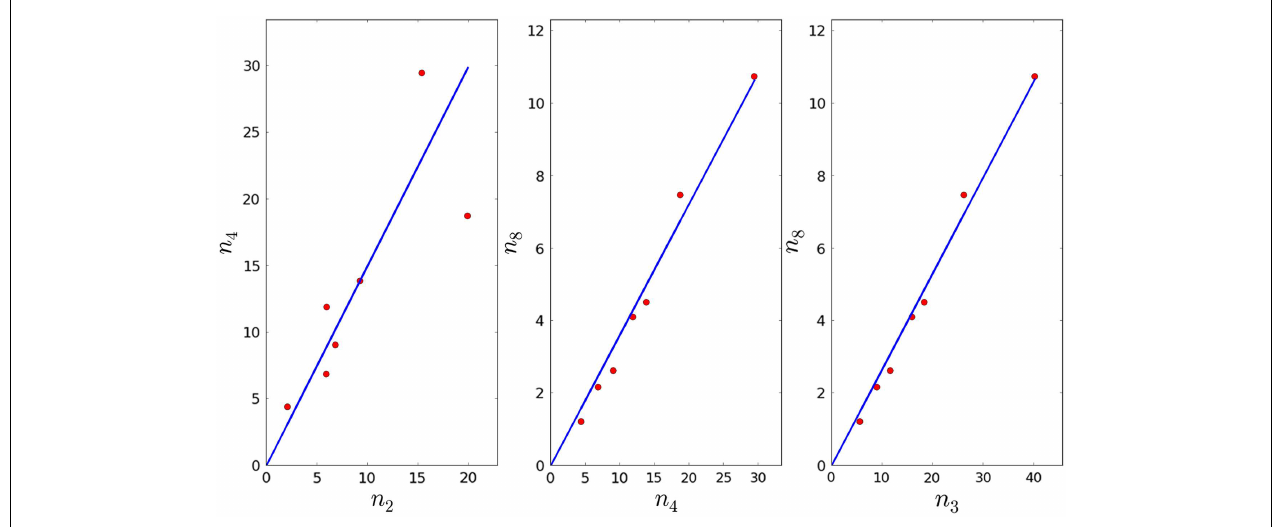
FIGURE 4 | Linear regression plots for the second model